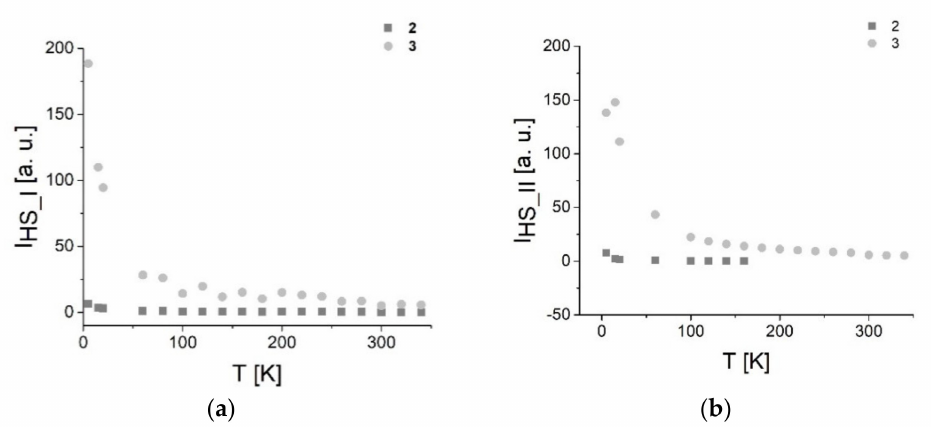
Figure 9. The temperature dependences of the integrated intensity of I-type ( a ) and II-type ( b ) HS Fe(III) centers in 2 and 3 .